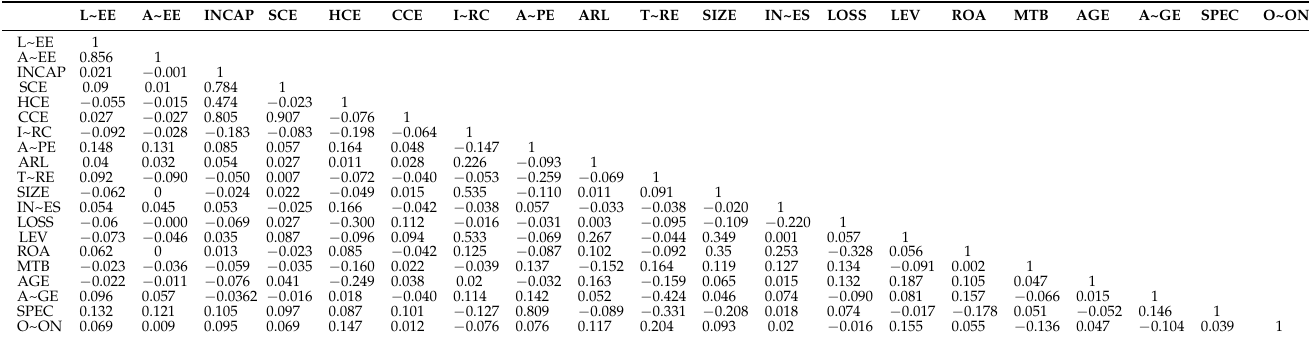
Table A5. The correlation matrix results of research model variables.